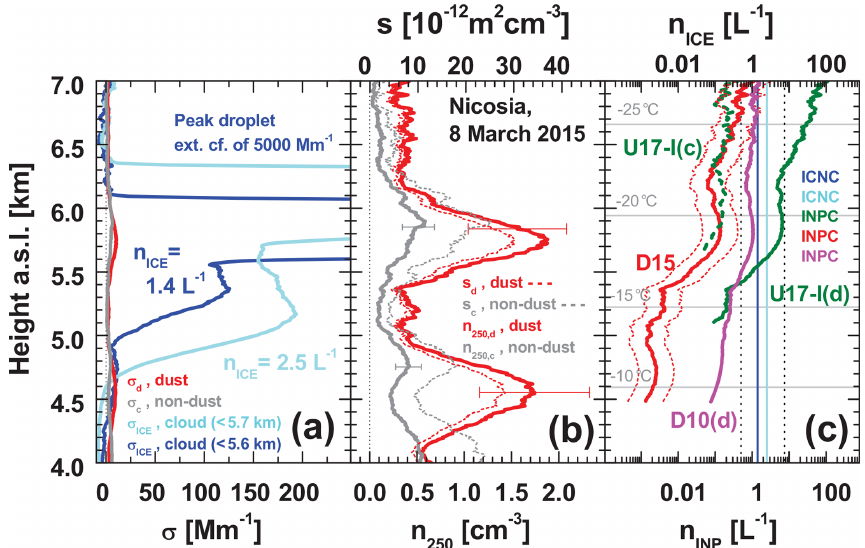
Figure 17. Mixed-phase-cloud INPC–ICNC closure study based on lidar observations over Nicosia on 8 March 2015 (see Fig. 5a and b). (a) Dust (red) and non-dust (grey) particle extinction coefficient (22:00–22:20UTC mean values, as shown in Fig. 16b), ice crystal extinction coefficient (blue, 22:29–22:31UTC mean, ice virga from 5 to 5.6km; light blue, 22:43–22:53UTC mean, ice virga from 4.7 to 5.7km), and estimated ICNC values ( n ICE in blue and light blue for the two time periods); (b) dust (red) and non-dust (grey) particle number concentration n 250 , d and n 250 , c (thick lines) and surface area concentration s d and s c (thin dashed lines, 22:00–22:20UTC mean values); (c) INPC values ( n INP , 22:00–22:20UTC mean) determined by using the immersion freezing INP parameterizations U17-I(c) (dotted dark green) for non- dust continental aerosol and D10(d) (magenta, thick solid) and D15 (red, thick solid, cf = 1.0), and U17-I(d) (dark green, thick solid) for the dust aerosol fraction. The uncertainty range (factor 3) of each of the four INPC profiles is indicated for D15 only (red dotted lines). The ICNC values (numbers in a ) are shown again, but here they are shown as vertical dark-blue and light-blue lines with the overall uncertainty range as vertical black dashed